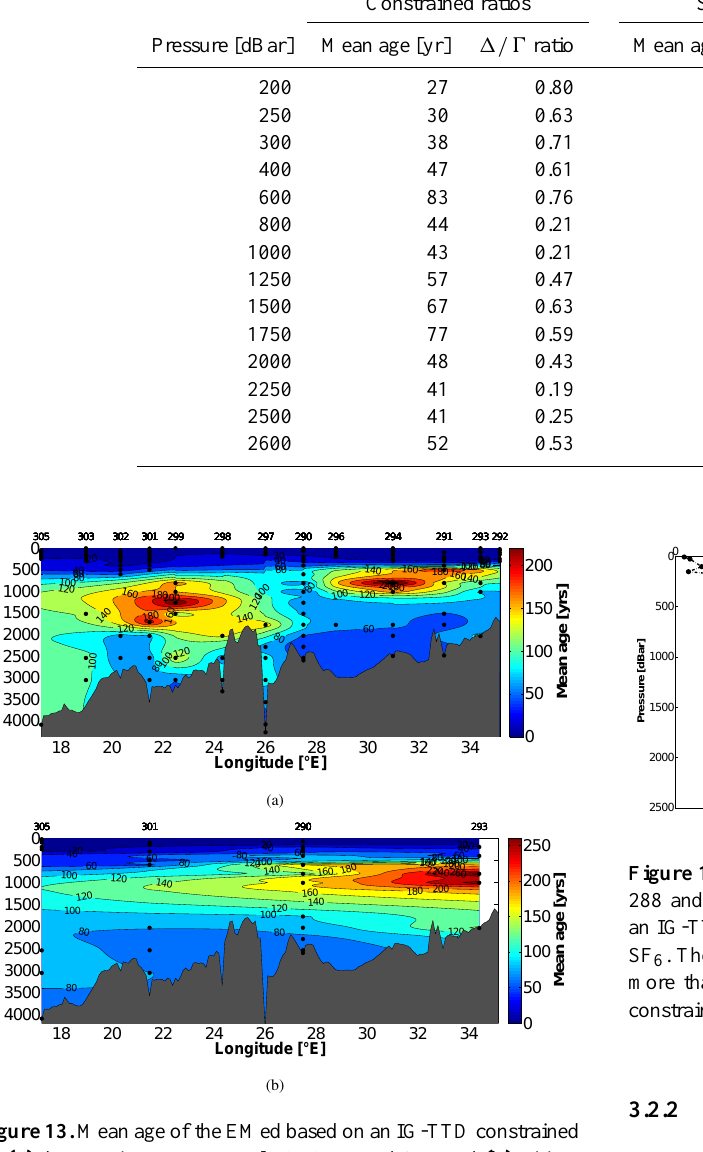
Fig.15:MeanagefunctionsofCFC-12andSF 6 atstation288,( a )intheCretanSeaat2030mdepthand( b )atstation313in theAdriaticSeaat1094mdepthwithanerrorrangeof4%analyticalerror.